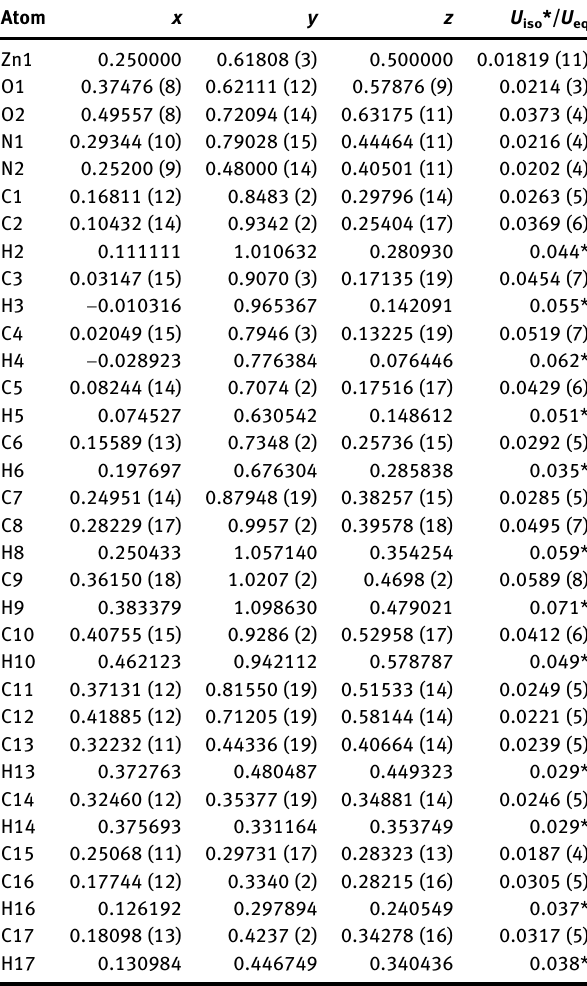
Table  : Fractional atomic coordinates and isotropic or equivalent isotropic displacement parameters (Å  ).